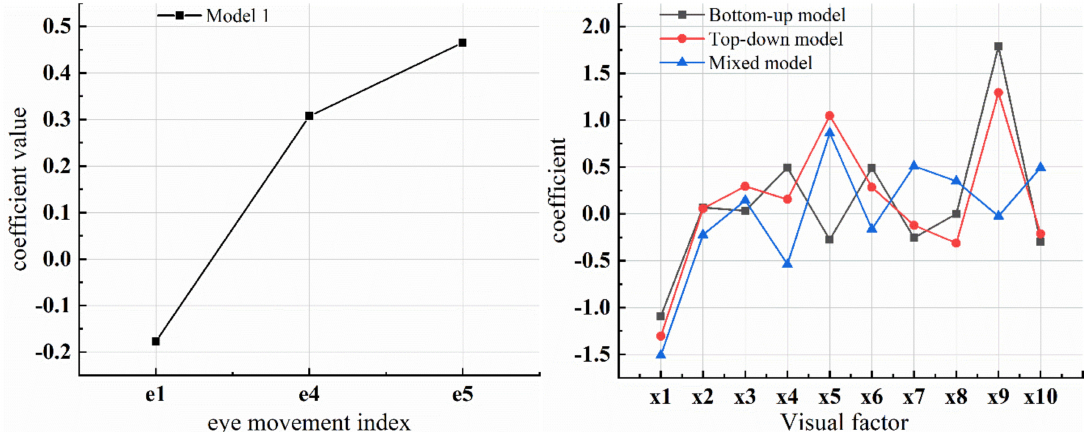
Figure 6. Statistical results of model independent variables’ influence coefficients. e 1 is “Time to first fixation”, e 4 is “Average visit duration”, e 5 is “Visit count” ( Left ). x 1– x 10 are different degree of “Hue”, “Saturation”, “Value”, “MBR”, “Aspect Ratio”, “Rectangularity”, “Area Convexity”, “Perimeter Convexity”, “Sphericity”, and “Form Factor”, respectively ( Right